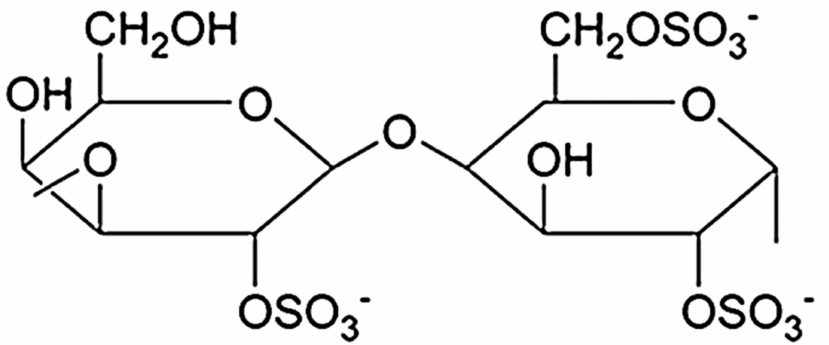
Figure 5. Chemical structure of the repeating unit of λ